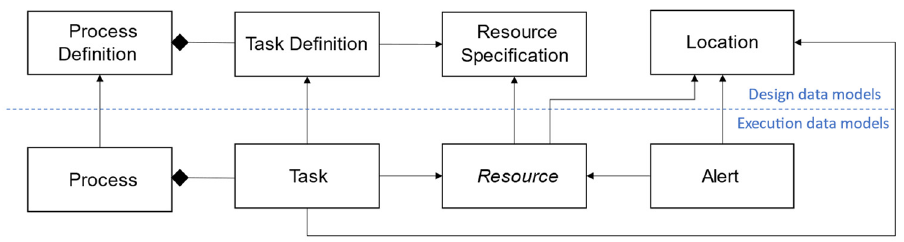
Figure 3. Data models used in project SHOP4CF. The data models are divided in the design and execution classes. The latter is used for exchanging information during operation, the former is focused on exchanging data during the design of the application [52].